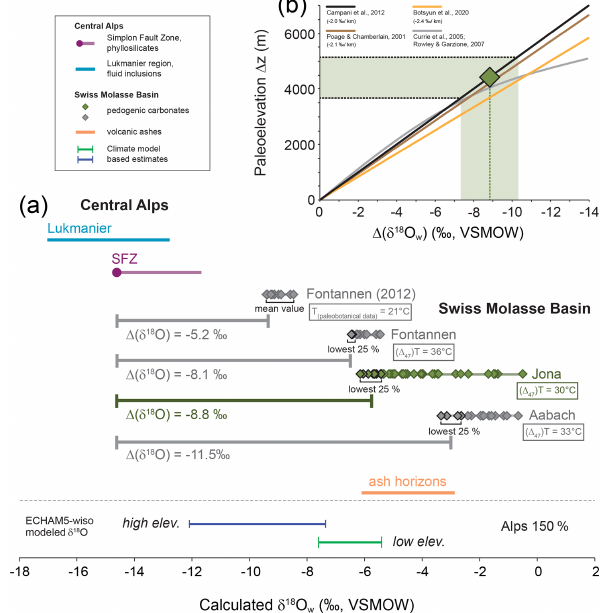
Figure 6. Paleoelevation calculation of the Miocene Central Alps. (a) The difference of precipitation δ 18 O w values ( (cid:49)(δ 18 O)) be- tween the high-elevation (Simplon Fault Zone; Campani et al., 2012) and the low-elevation sites (Fontannen, Jona, Aabach) is a measure of the respective elevation difference. We use a conserva- tive approach to calculate the paleoelevation and only consider the lowest 25% δ 18 O w values ( n = 10) of the mid-fan-situated Jona section as most suitable to serve as a low-elevation reference base- line (see text for discussion). Swiss Molasse Basin precipitation δ 18 O w values were calculated from pedogenic carbonate δ 18 O c values using carbonate clumped isotope ( (cid:49) 47 ) formation temper- atures. The figure shows foreland data from this study (Fontan- nen, Jona and Aabach) and from Campani et al. (2012; Fontan- nen, 2012). Also shown are quartz vein fluid inclusion δ 18 O w val- ues from the Lukmanier region (Swiss Alps; Sharp et al., 2005), δ 18 O w values derived from volcanic ashes (Bauer et al., 2016), and the modeled range for high- and low-elevation precipitation δ 18 O w values for the present-day Alps150 (ECHAM5-wiso iGCM run; Botsyun et al., 2020). (b) Jona (cid:49)(δ 18 O) value and inferred el- evation differences ( (cid:49)z ; m) (horizontal green rectangle) are based on different isotope lapse rates. Black line: − 2 . 0‰km − 1 (Cam- pani et al., 2012); brown line: − 2 . 1‰km − 1 (Poage and Chamber- lain, 2001); yellow line: − 2 . 4‰km − 1 (Botsyun et al., 2020); grey line: Currie et al. (2005), Rowley and Garzione (2007). The uncer- tainty in (cid:49)(δ 18 O) is ± 1 . 5‰. The present-day Alpine δ 18 O w lapse rate of − 2 . 0 ± 0 . 04‰km − 1 translates the Jona (cid:49)(δ 18 O) value of − 8 . 8 ± 1 . 5‰ to a paleoelevation difference of 4420 ± 770m (dashed lines in black) between the foreland basin and the intra-Alpine